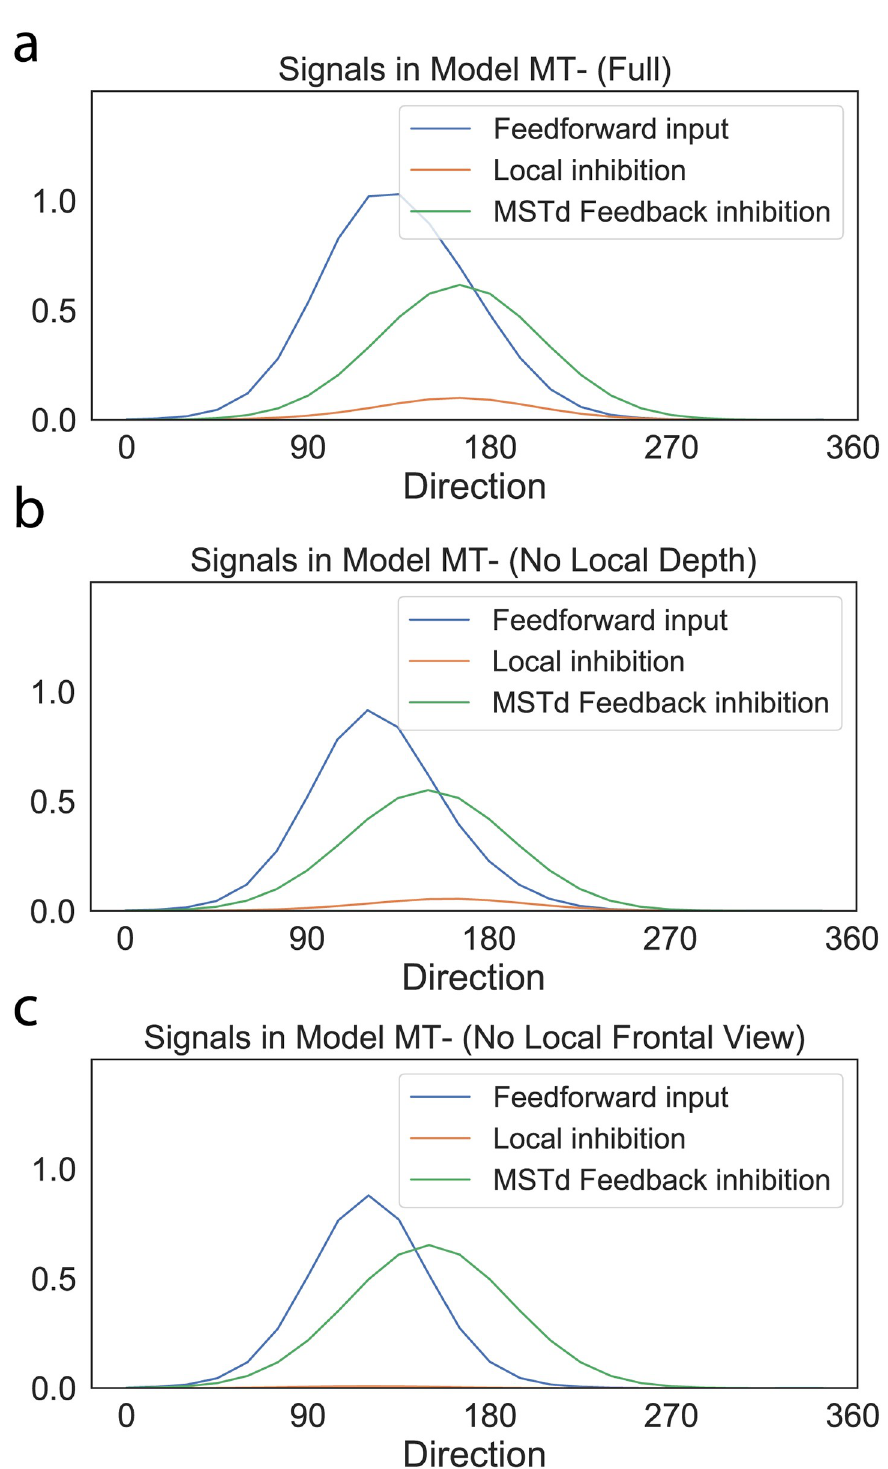
Fig 12. Object motion signals in MT in the (a) Full Stereo, (b) No Local Depth, and (c) No Local Frontal View conditions. Blue is the object motion signal in MT − , green is the inhibitory feedback signal from MSTd, red is the surround (local) inhibition within MT. y-axis is activation, x-axis is direction (0–360˚ in 15˚ increments). Local inhibition refers to the inhibitory signal due to feedforward lateral inhibition from units tuned to similar directions, speeds, and disparities in MT Layer